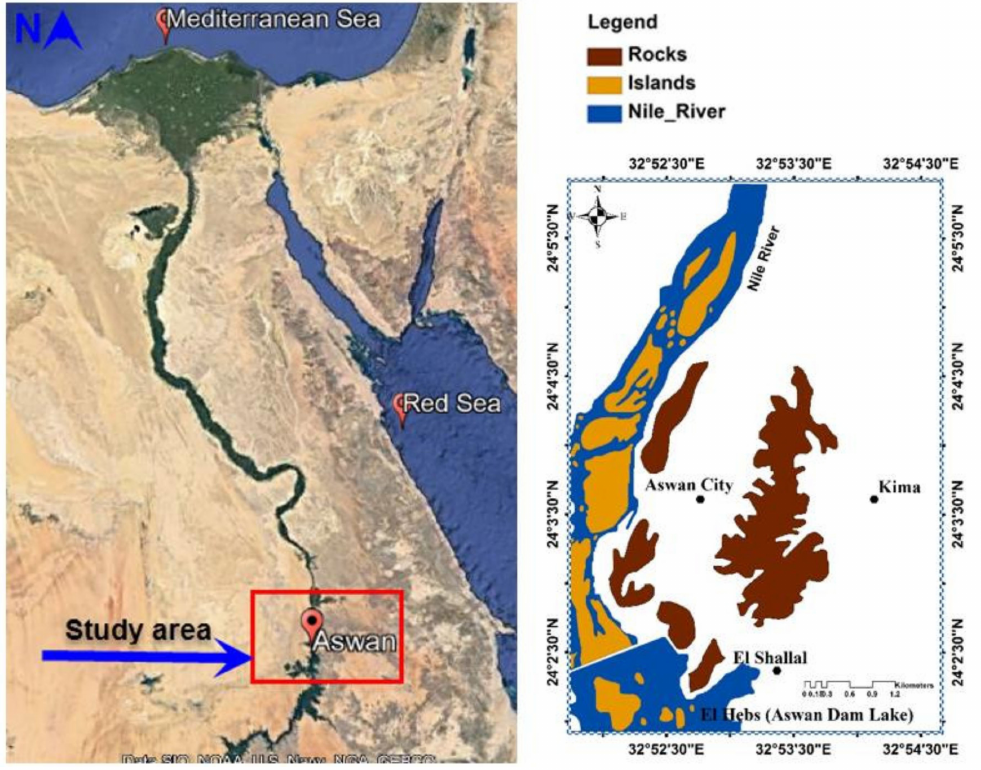
Figure 3. Location map for study area.